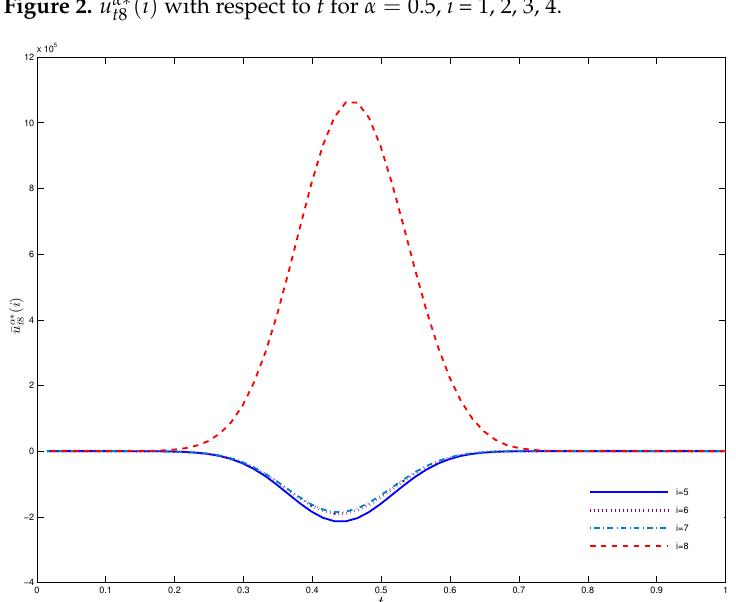
( i ) with respect to t for α = 0.5, i = 5, 6, 7, Figure 3. ¯ u α ∗ t 8